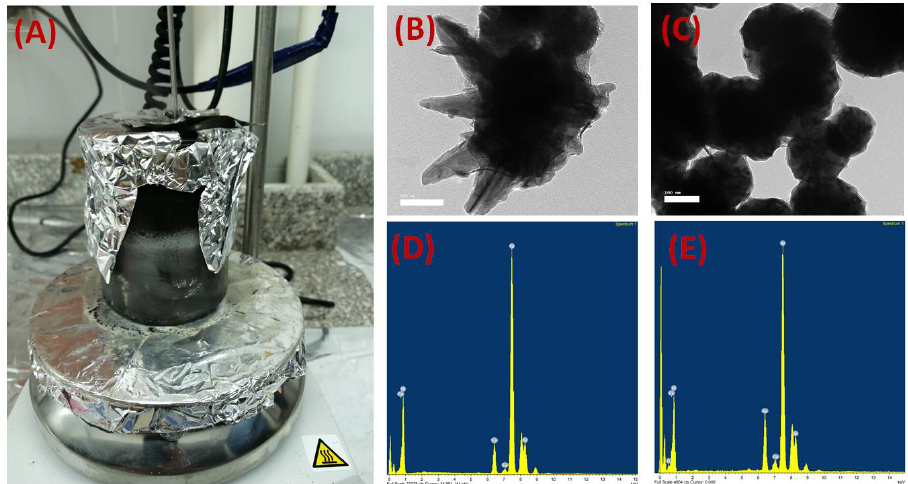
Figure 1. Photos of the prepared iron–nickel alloys during the reduction process ( A ), TEM images of the prepared Fe 10 Ni 90 —starfish-like alloy ( B ) and Fe 20 Ni 80 —necklace-like alloy ( C ), and EDX analysis of the prepared alloys (( D ) and ( E ), respectively).